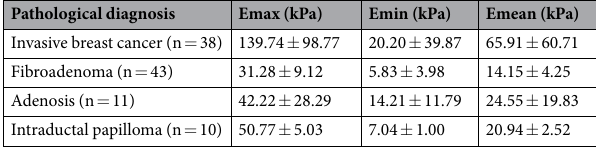
Table 1. Emax, Emin and Emean of different pathology breast